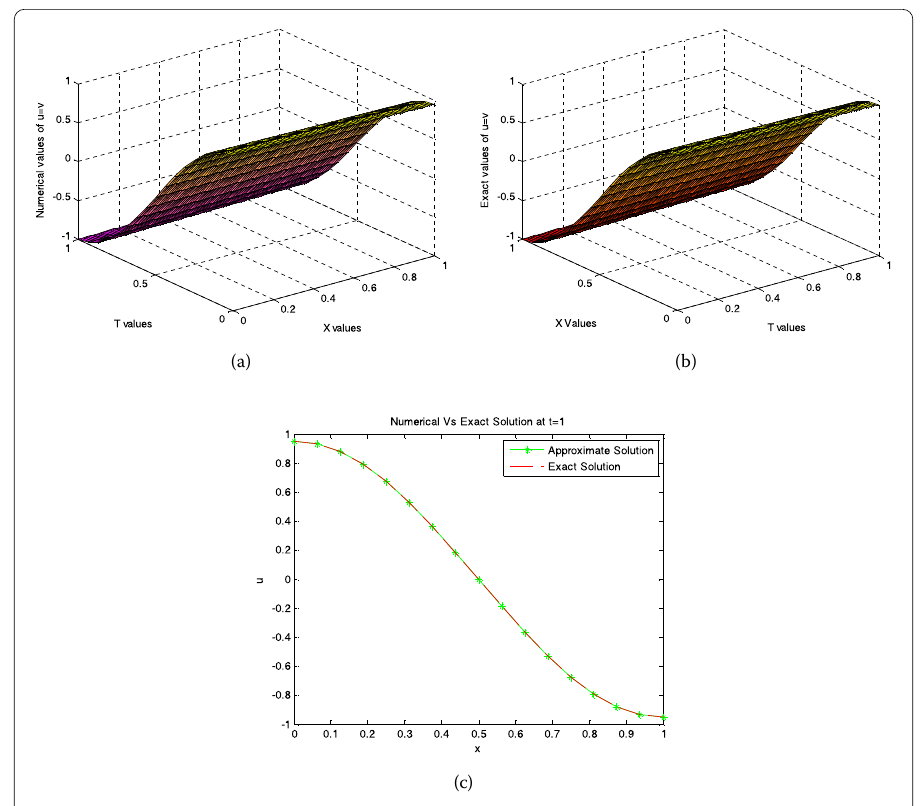
Figure 5 Example 8: The graphs of numerical and exact solutions for the values α 1 = β 1 = 2, α